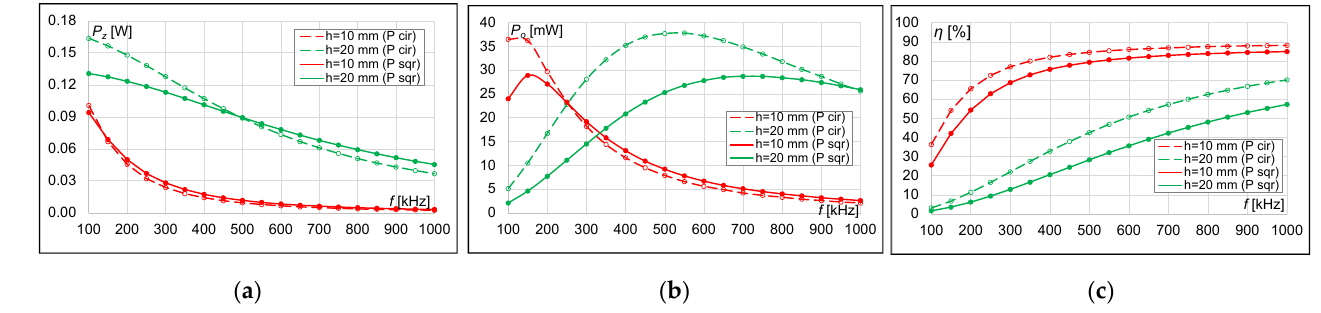
Figure 23. Results for the periodic system with circular or square coils with r = 20 mm and the number of turns n = 60 at two distances ( h = 10 mm and h = 20 mm): ( a ) transmitter power, ( b ) receiver power, ( c ) power transfer efficiency.